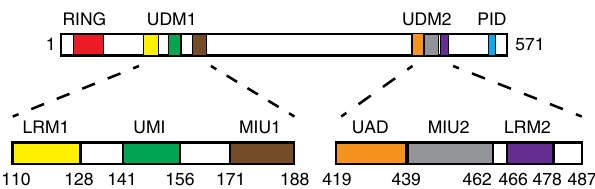
Fig. 1 Functional motifs in human RNF168. RING, LRM1, UMI, MIU1, UAD, MIU2, LRM2, and PALB2-interacting domain (PID) are shown as red, yellow, green, brown, orange, gray, purple, and light blue boxes,